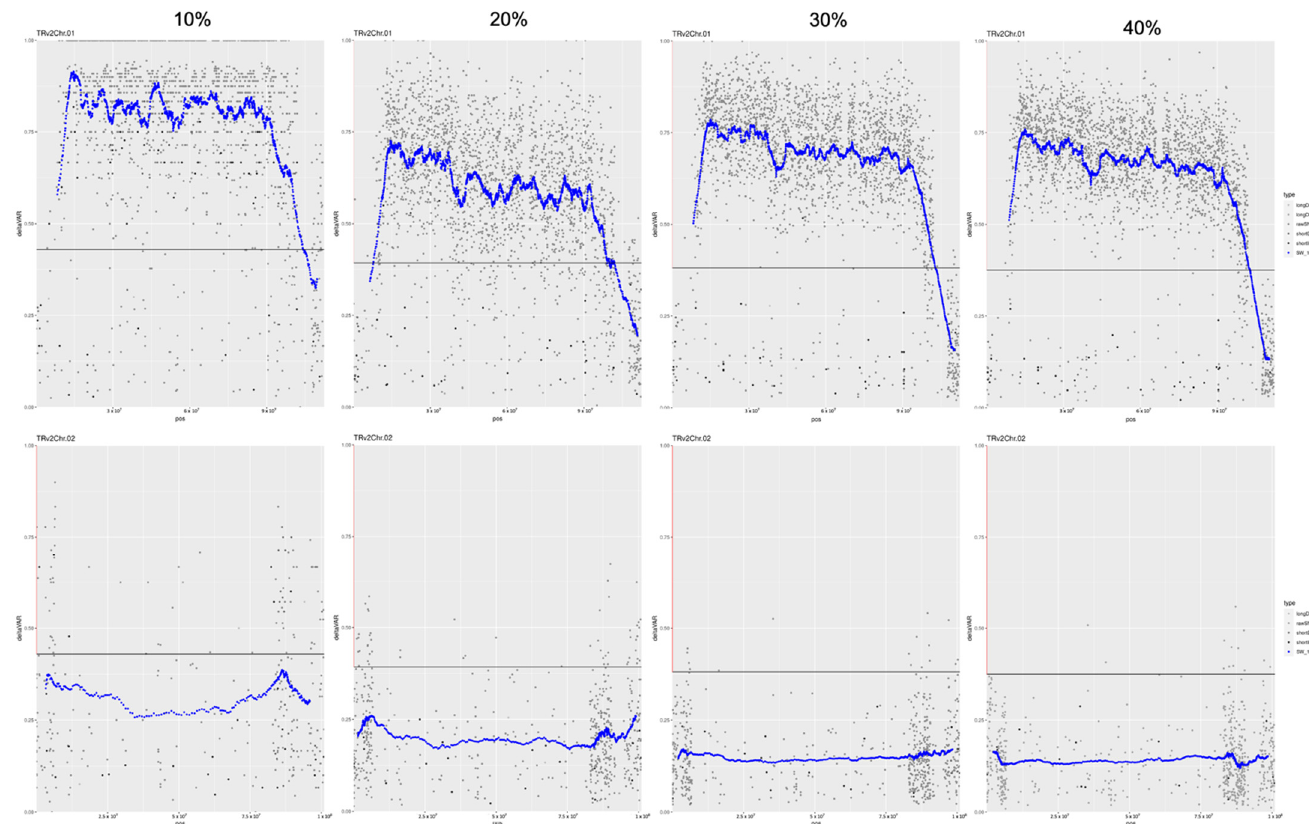
Figure 3. in silico bulking and QTL-seq analysis of TSWV resistance. A major QTL is identified on chromosome A01 (top). We tested bulking 10%, 20%, 30%, and 40% of the population (left to right). The bottom shows the same bulk percentages for a chromosome with no signal (A02). Notice the noise decreases significantly as bulk% increases.